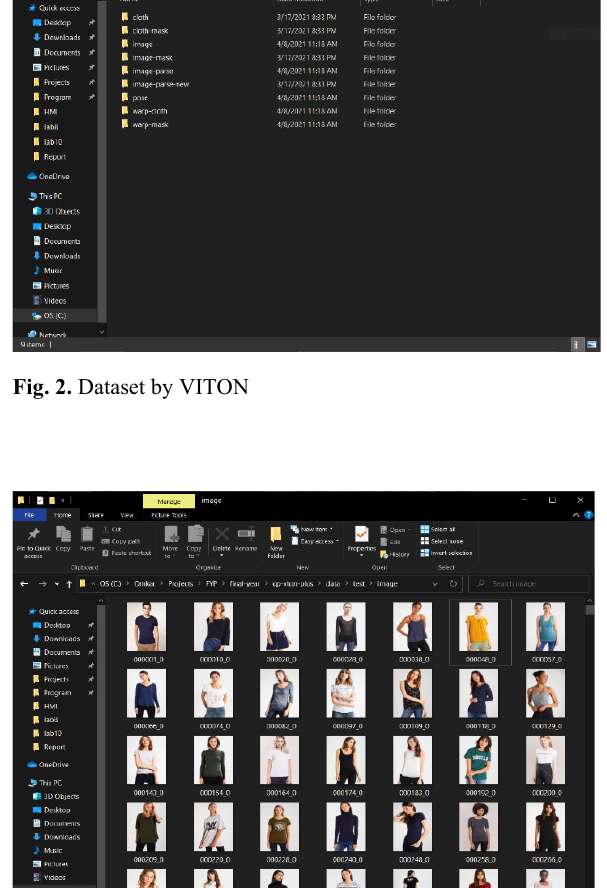
Fig. 4. CIHP-PGN input output